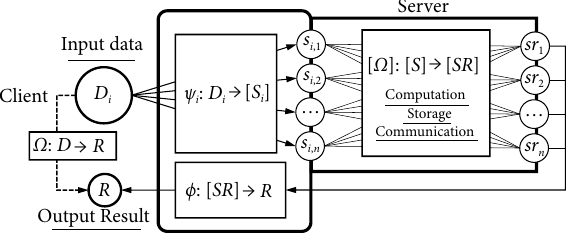
Fig. 1 Schematic diagram of the SMPC protocol based on SSS.